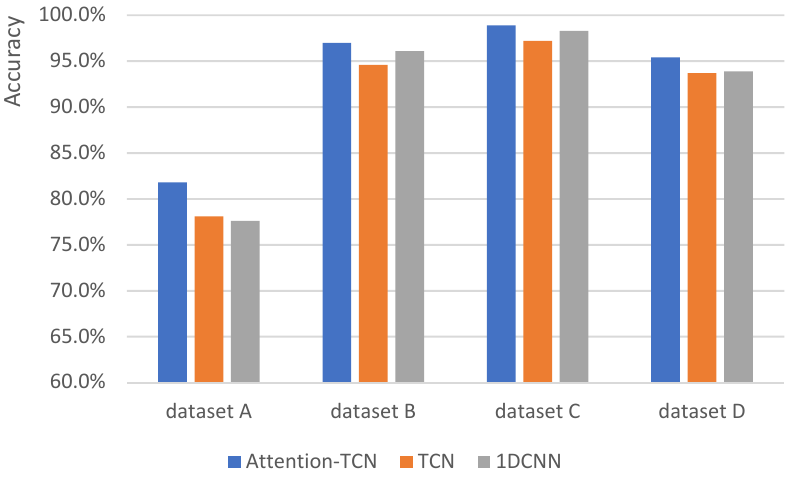
Figure 6. The average accuracy of the three networks on the four datasets.